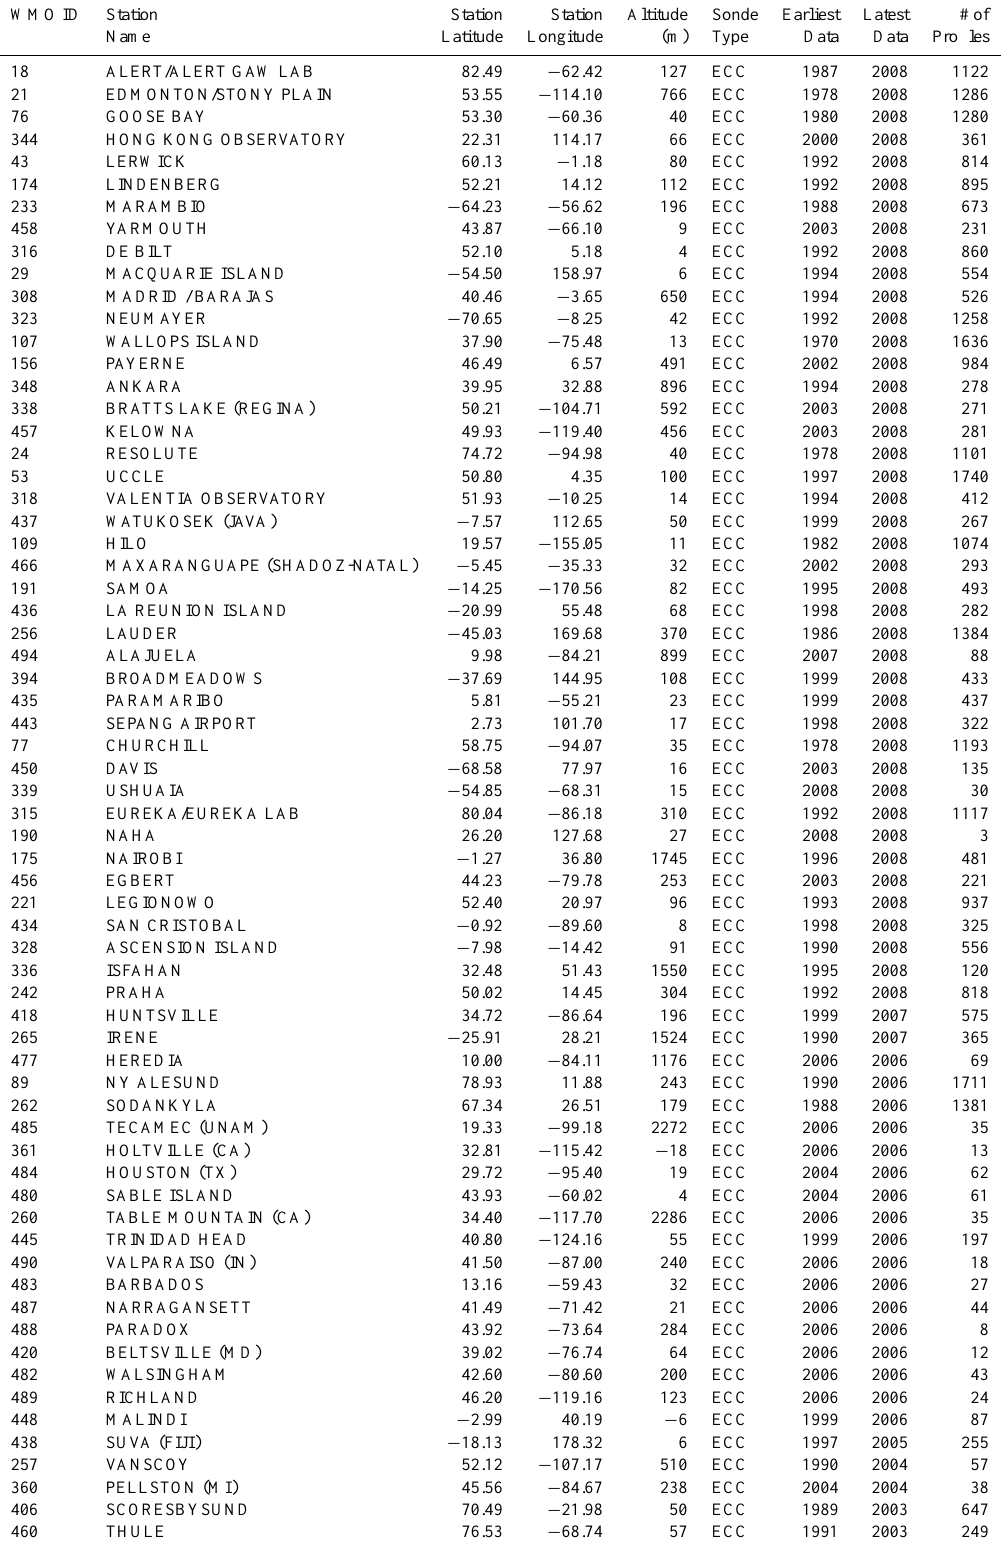
Table 1. Ozonesonde stations used in this study and their respective data spans. (BM = Brewer–Mast; KC = Japanese KC series; CI =